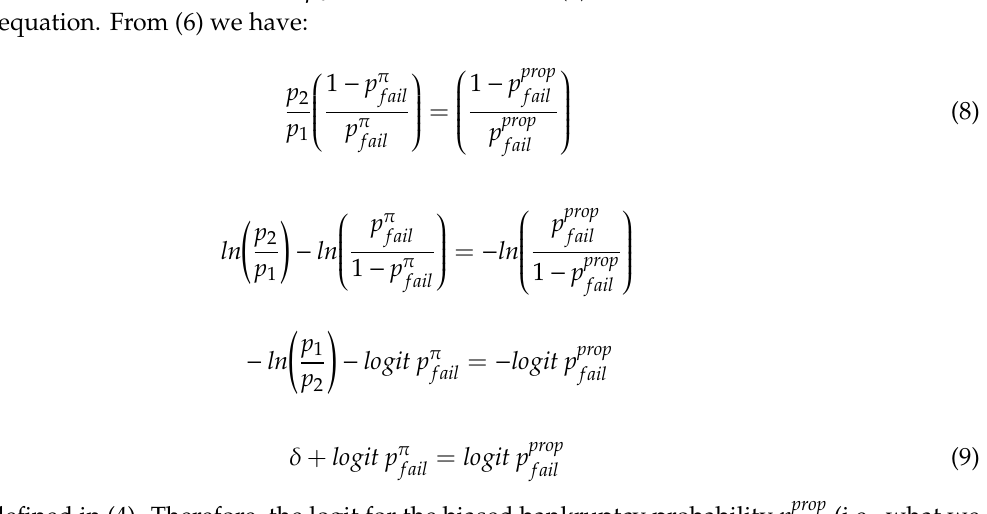
Figure 1. Plot of population adjusted PD (probability of default; p π π = 0.02 and prop = for and . 𝜋𝜋 = 0.02 𝑝𝑝𝑝𝑝𝑙𝑙𝑝𝑝 = 0.5